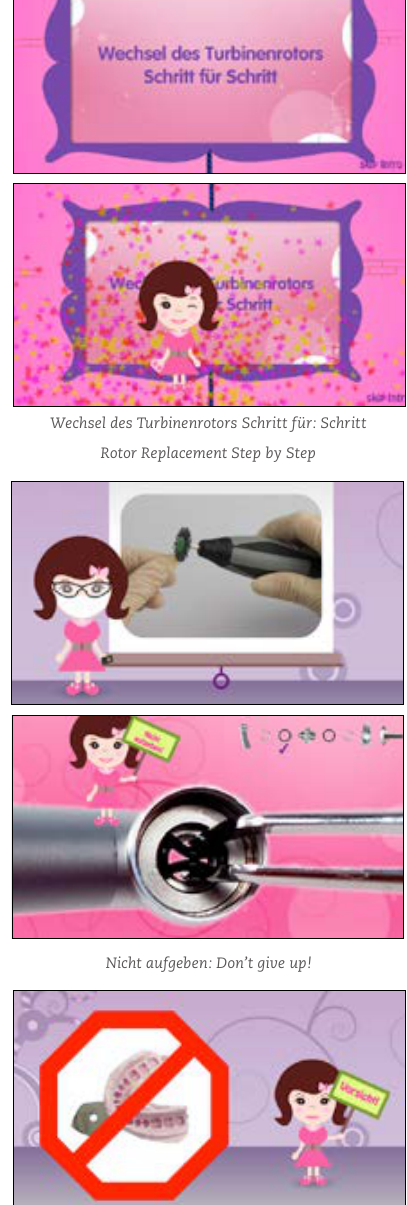
Figure 7: Technical processes (turbine rotor replacement) contrast with a playful look (decorative elements, framing,